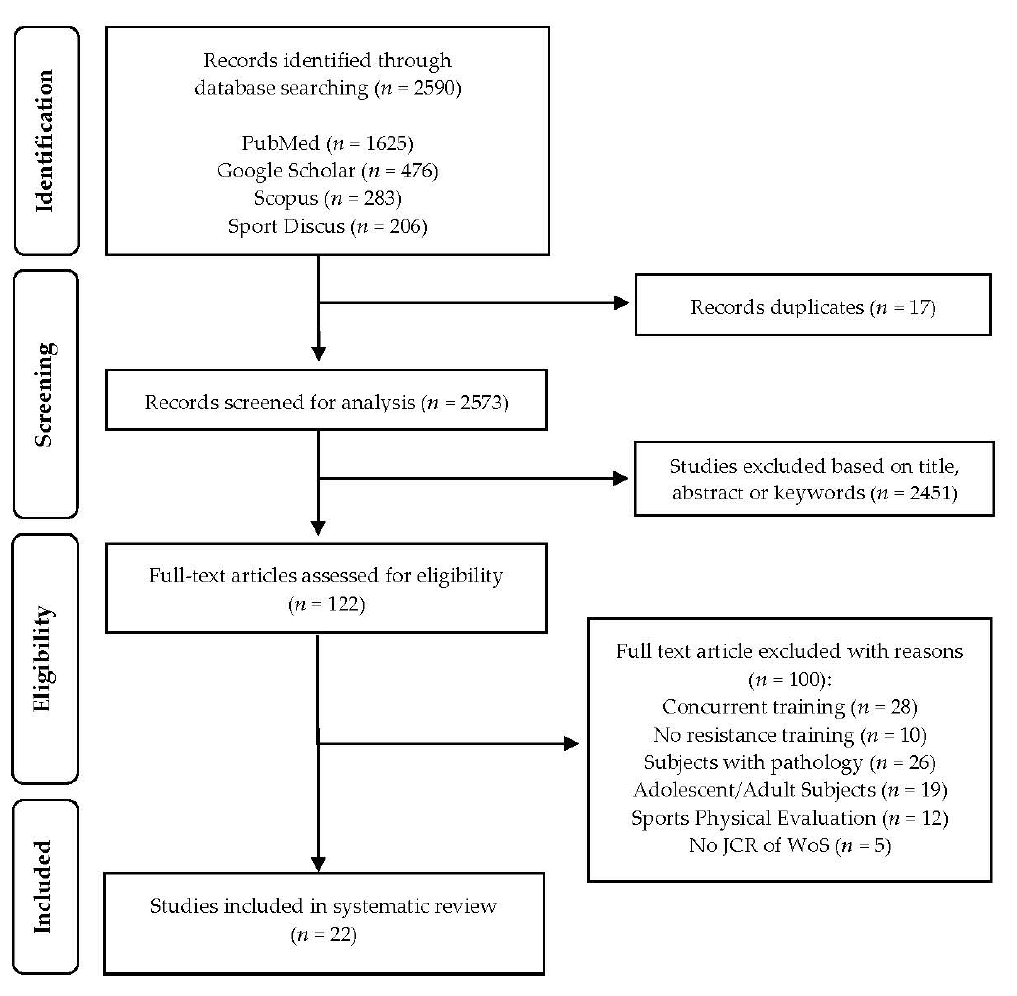
Figure 1. Flow diagram for screening and selection of studies according to Preferred Reporting Items for Systematic Reviews and Meta ‐ Analysis (PRISMA).